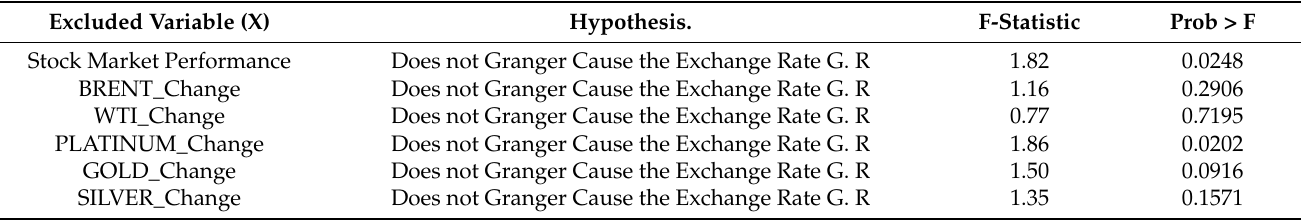
Table A11. Granger Causality test related to the Exchange Rate G. R (Regression with Driscoll–Kraay Approach).